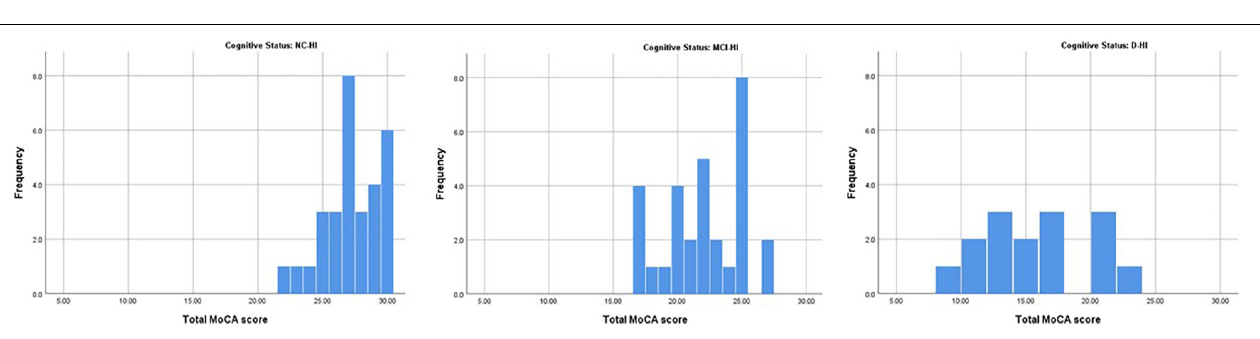
FIGURE 2 | The histograms demonstrated the distribution of MoCA-HA score of the NC-HI, the MCI-HI and the D-HI